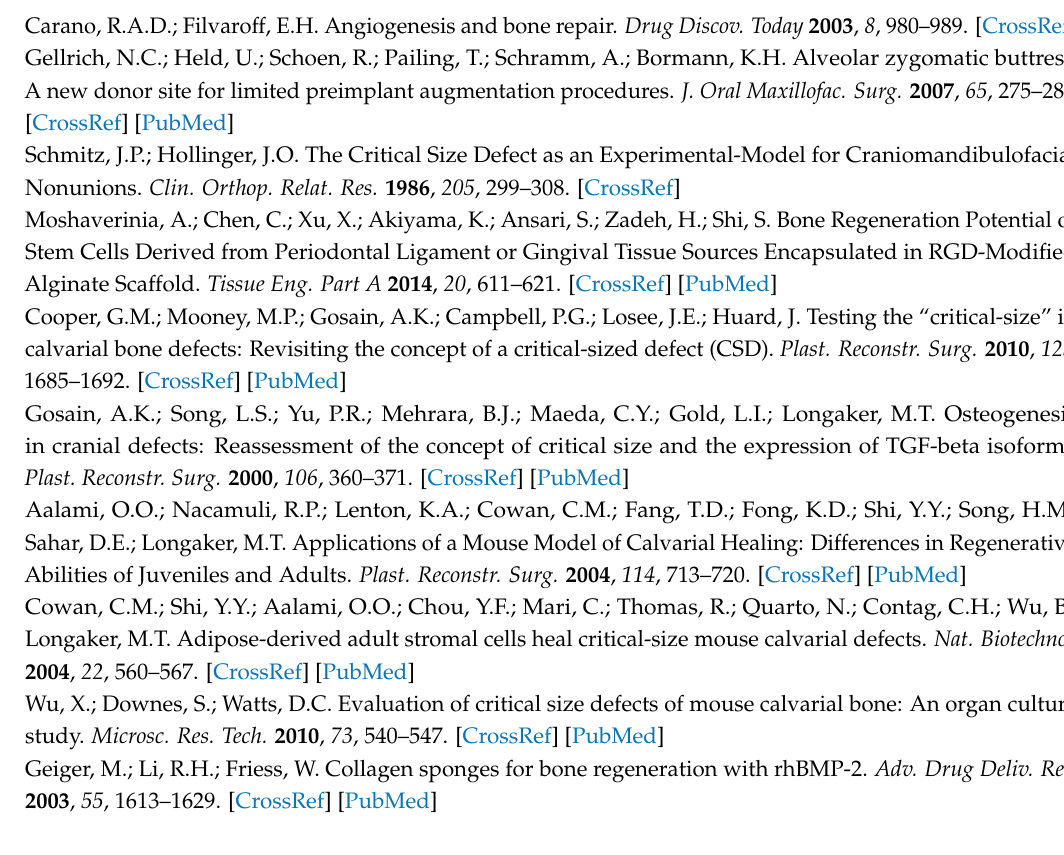
Table S1: Median values and standard deviations for bone volume, implant volume, bone area, osteoid proportion and blood vessel observations. Figure S1: Exemplary µ CT scan of a mouse treated with an uncoated titanium implant at day 0 (rostrocaudal view; i = implant with artefacts, s = skull); Figures S2–S29: Histological images of trichrome-masson-goldner stained thin sections of mice without implant (only defect; control group 1); Figures S30–S53: Histological images of trichrome-masson-goldner stained thin sections of mice treated with titanium implant (control group 2); Figures S54–S75: Histological images of trichrome-masson-goldner stained thin sections of mice treated with non-previtalised hybrid implant; Figures S76–S102: Histological images of trichrome-masson-goldner stained thin sections of mice treated with hybrid implant previtalised with murine osteoblasts; Figures S103–S124: Histological images of trichrome-masson-goldner stained thin sections of mice treated with hybrid implant previtalised with murine